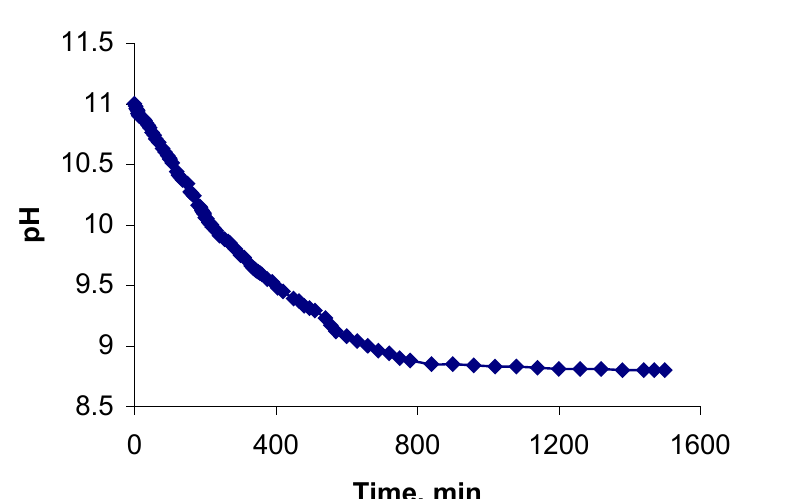
Figure 6. Time variation of pH for the release, in a basic medium, of OxBBI from the OxBBI-gellan system (OxBBI content = 22.29 %).